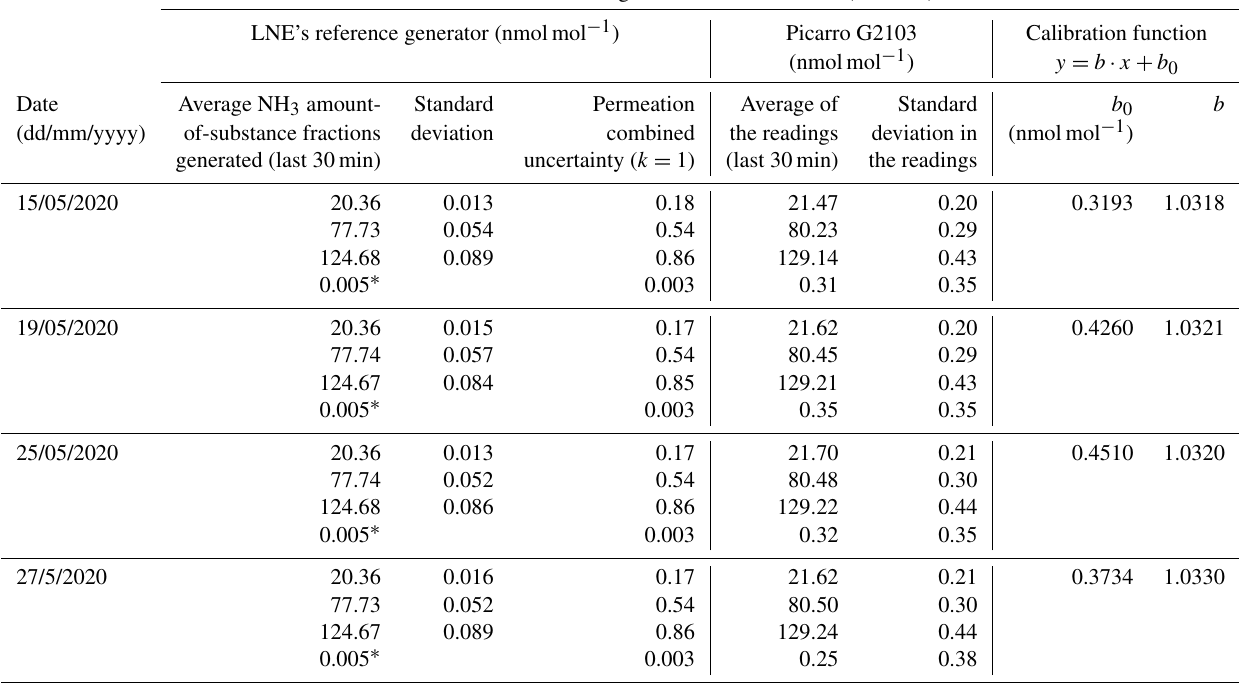
Table 5. Tests were performed to determine reproducibility of the calibration of an ammonia analyzer using the reference generator from LNE and the Picarro NH 3 analyzer from METAS. The coverage factor ( k ) is indicated for the combined uncertainty of the permeation. The calibration function is also included, where y are the readings, x are the average NH 3 amount-of-substance fractions generated, b is the slope, and b 0 the intercept.